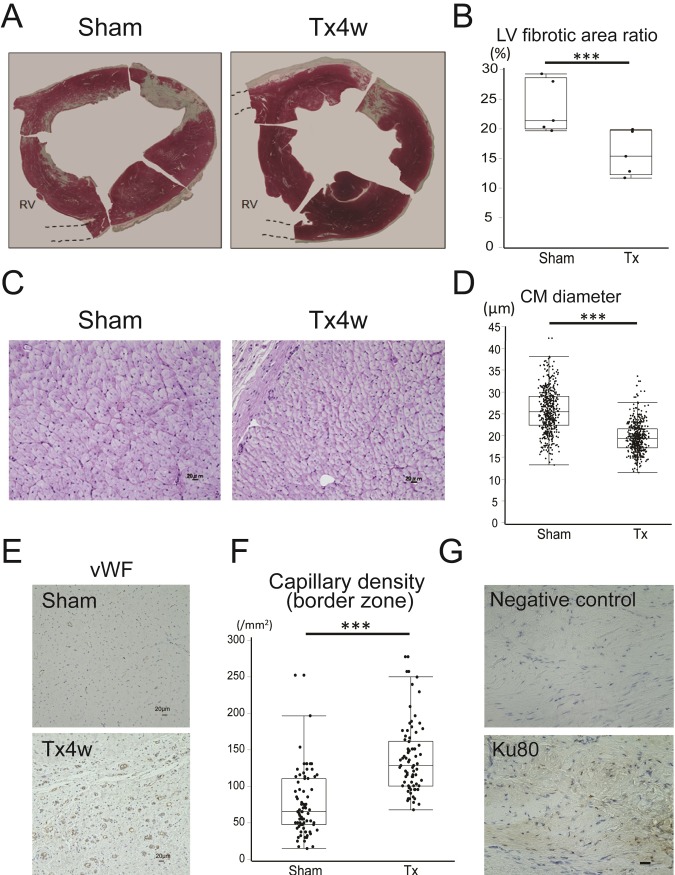
Attenuation of LV remodeling after L-CTS transplantation.(A) Representative Masson’s trichrome staining at 4 weeks after transplantation. RV, right ventricle (removed). (B) The ratio of fibrotic area to the whole heart area. ***p<0.001. (C) Representative PAS staining of border region at 4 weeks after transplantation. Scale bar = 20 μm. (D) Cardiomyocyte diameter. ***p<0.001. (E) Representative vWF staining 4 weeks after L-CTS transplantation (brown). Scale bar = 20 μm. (F) Capillary density at border region. ***p<0.001. (G) Representative Ku80 staining (brown). Scale bar = 20 μm.